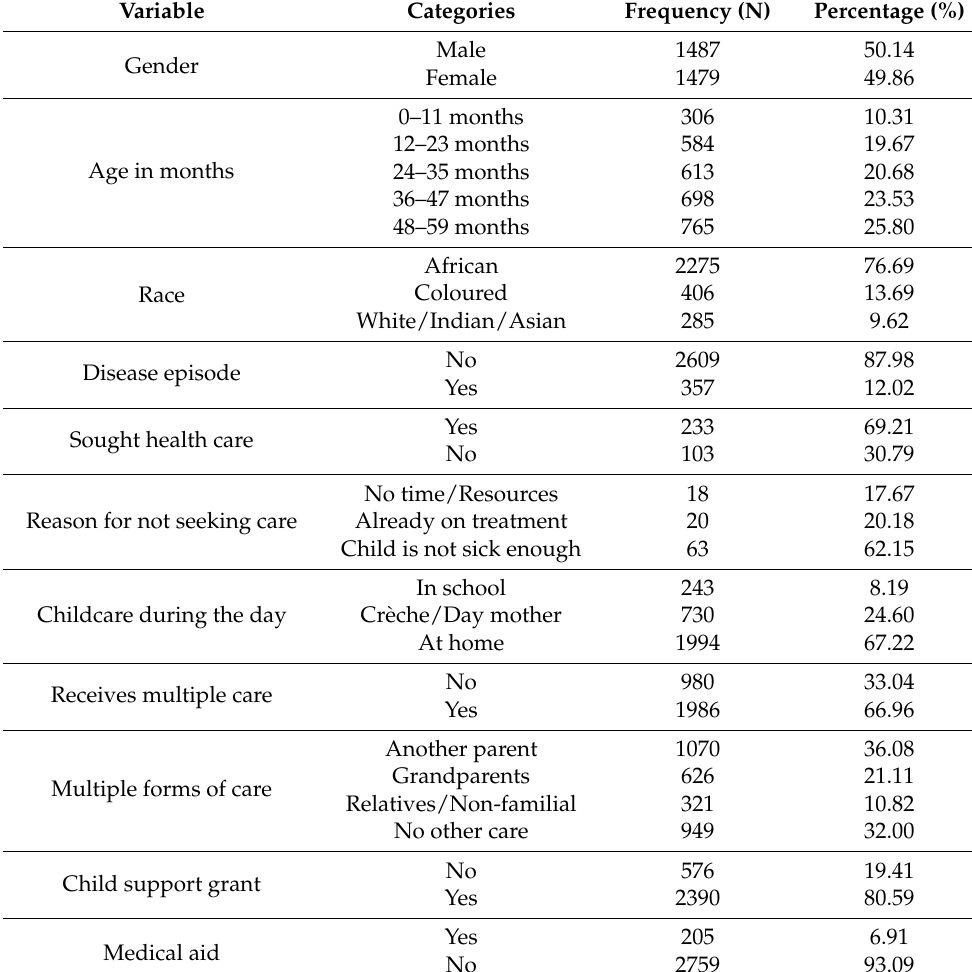
Table 2. Child-level characteristics (N = 2966).